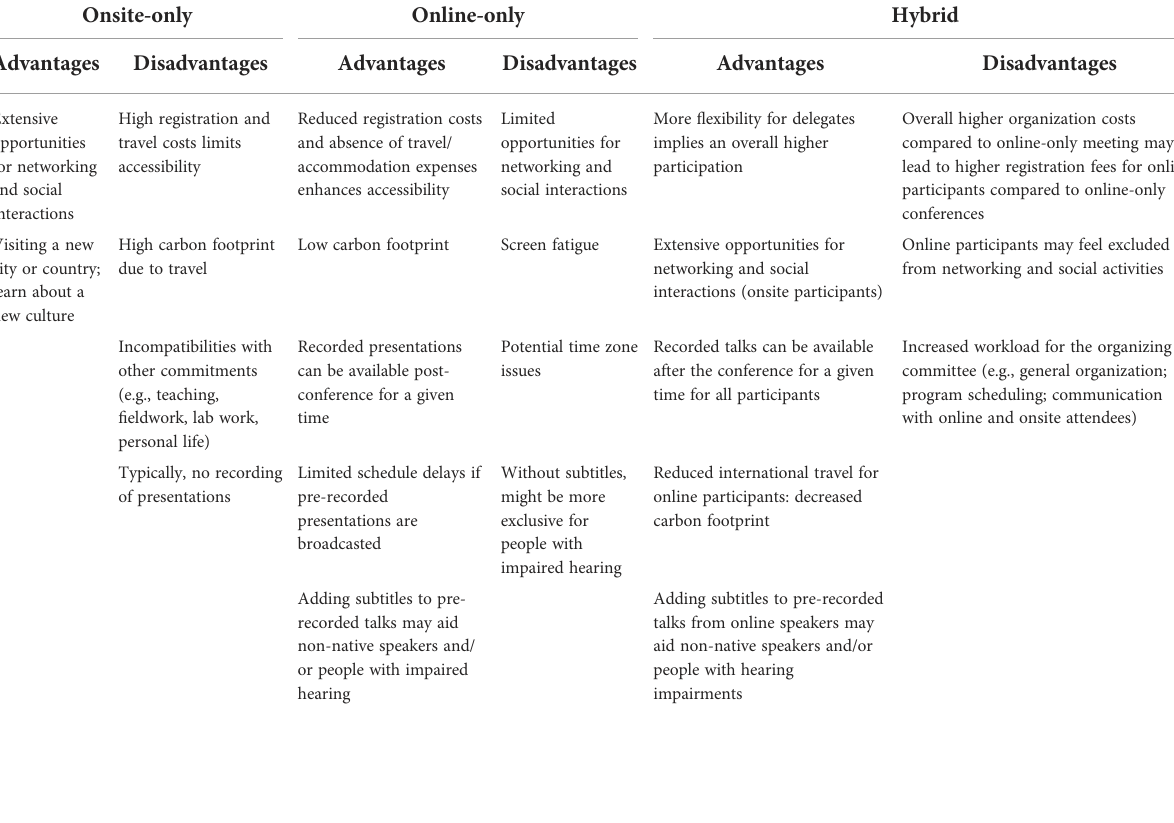
TABLE 4 Summary of advantages and disadvantages of onsite-only, online-only and hybrid meetings for participants.